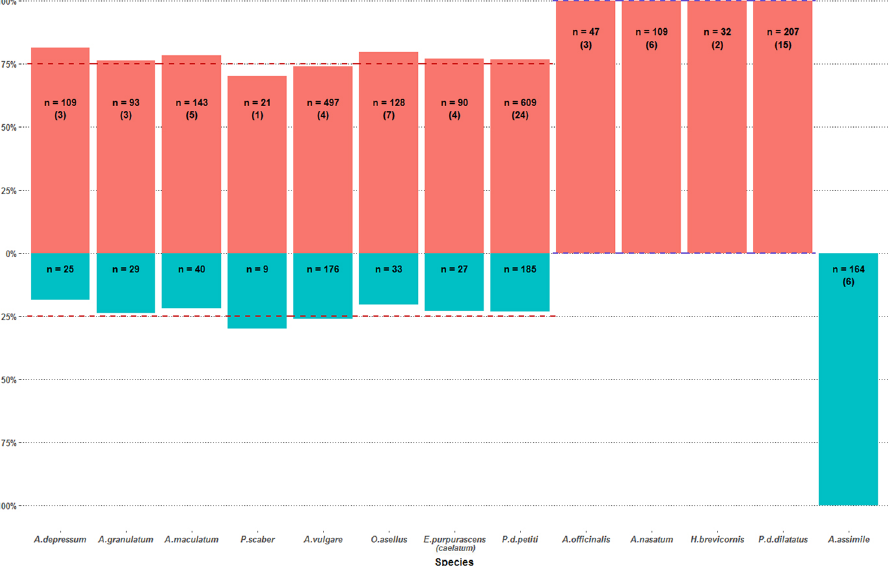
Figure 3. Sex ratio of progenies of 13 terrestrial isopod species resulting from crosses between genetic and sex- reversed females (neomales). Red and blue colors indicate the percentages of females and males, respectively. Red dashed lines indicate a 1/4 ♂ : 3/4 ♀ sex ratio (expected in ZZ/ZW systems) and blue dashed lines indicate a 0 ♂ : 1 ♀ sex ratio (expected in XY/XX systems). n is the number of pooled individuals per sex, and the number of corresponding progenies are specified in brackets for each